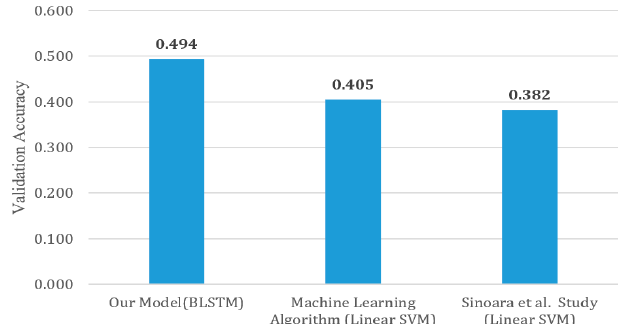
Figure 3. A comparison between the best scores of deep neural networks with BLSTM architecture, other common ML algorithms and a literature study. other common ML algorithms and a literature